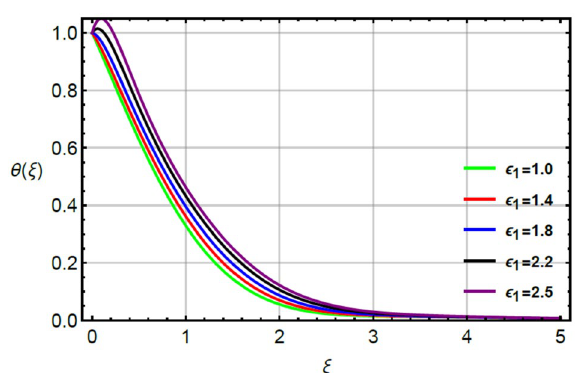
Figure 9. Character of ǫ 1 on θ .